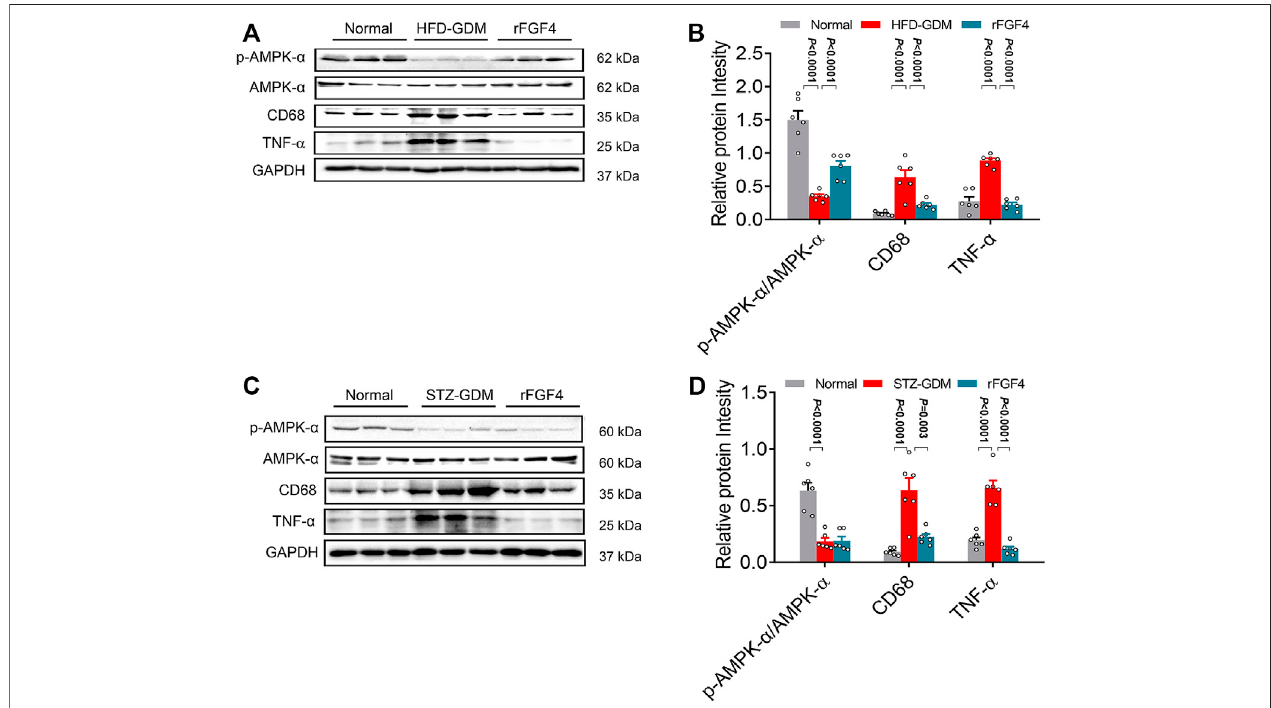
FIGURE6| PossiblemechanismofrFGF4treatmentintwodifferentGDMmicemodel. (A) ProteinlevelsofphosphorylationofAKT(p-AKT),p-AMPK/AMPK,CD68 andTNF- α intheplacentasofcontrol,HFDinducedGDMandrFGF4-treatedmice. (B) Densitometricquanti fi cationofwesternblotsshownin (A) .Dataarepresentedas mean values ±SEM ( n = 6); a value of p < 0.05 was considered to be statistically signi fi cant. (C) Protein levels of phosphorylation of p-AMPK/AMPK, CD68 and TNF- α in the placentas of control, STZ induced GDM and rFGF4-treated mice. (D) Densitometric quanti fi cation of western blots shown in (C) . Data are presented as mean values ±SEM ( n = 6); a value of p < 0.05 was considered to be statistically signi fi